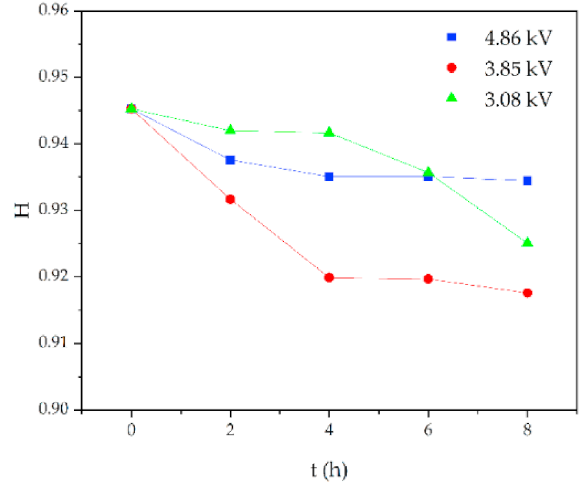
Figure 13. Changes in H values of samples with corrosion time (pH = 2.9).